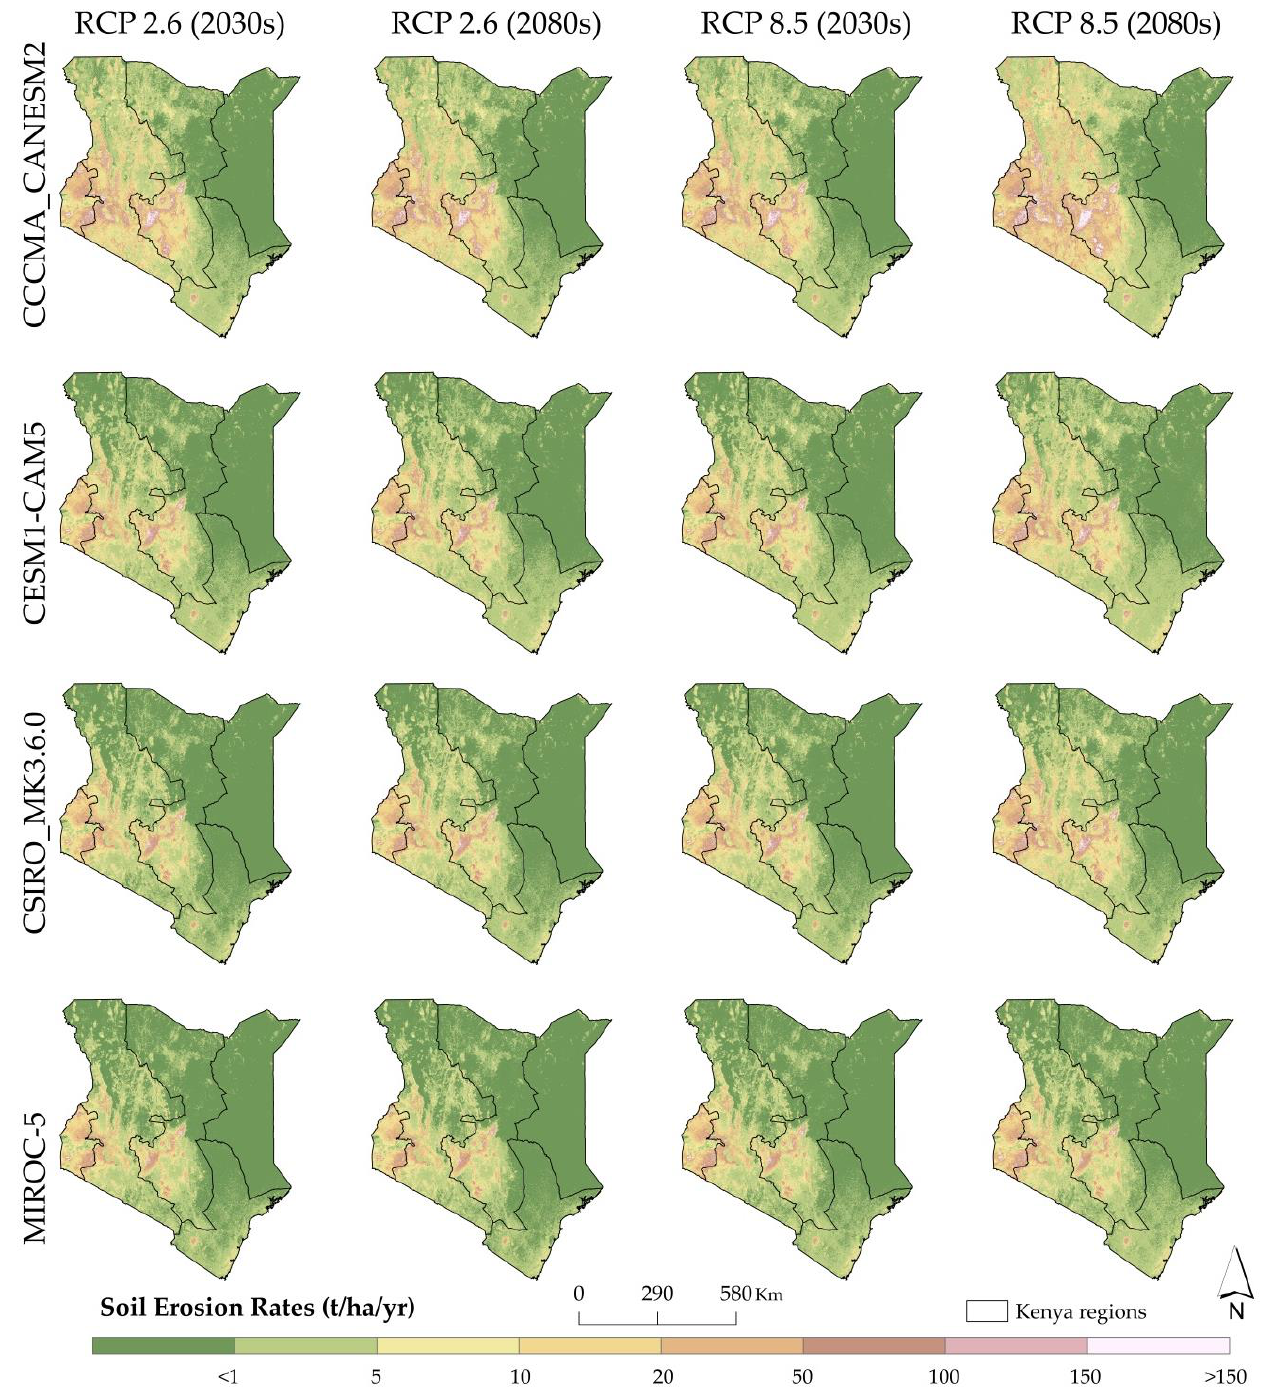
Figure 13. Soil erosion rates projections in Kenya for the periods of the 2030s and 2080s under RCP 2.6 and 8.5 scenarios, driven by CCCMA_CANESM2, CESM1-CAM5, CSIRO_MK3.6.0 and MIROC-5 GCMs.